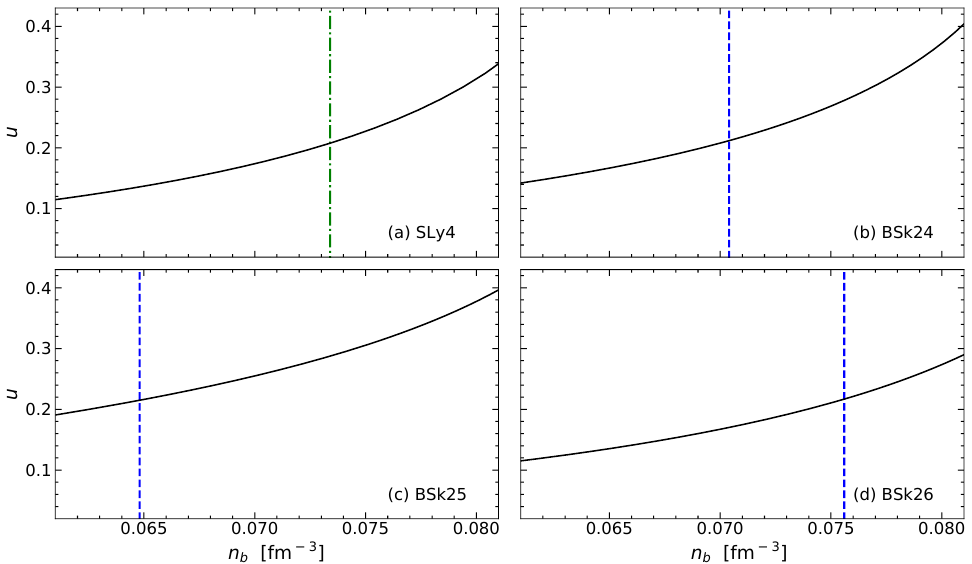
Figure 1. The filling factor for spherical nuclei as a function of nucleon number density. Panels ( a – d ) are plotted for the Skyrme potentials SLy4 [16,17] and BSk24, BSk25, BSk26 [18], respectively. The black solid line is the filling factor, the vertical lines represent maximal density of the spherical nuclei predicted to be energetically favourable. For the SLy4 model (panel a , dash-dot line) it corresponds to the transition from spherical to the uniform nuclear matter (neutron star core), while for BSk models (panels b – d ; dashed line), the transition to the cylindrical nuclei takes place. The plot is based on calculations of Ref.